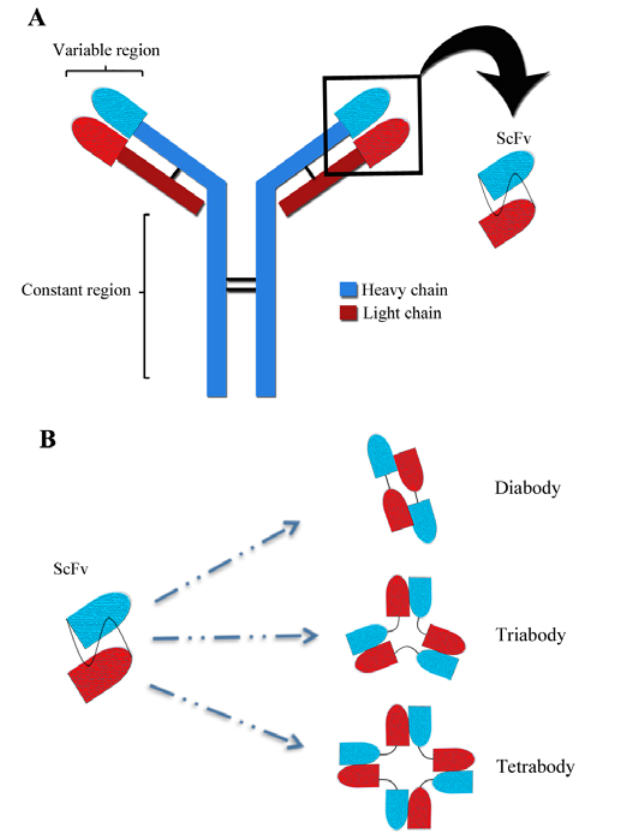
Figure 1. ( a ) Schematic representation of full-length monoclonal antibodies (mAb) and single chain variable domain (Fv) fragments (scFv) fragments. ( b ) scFv fragments can be engineered into multivalent species: diabody, triabody and